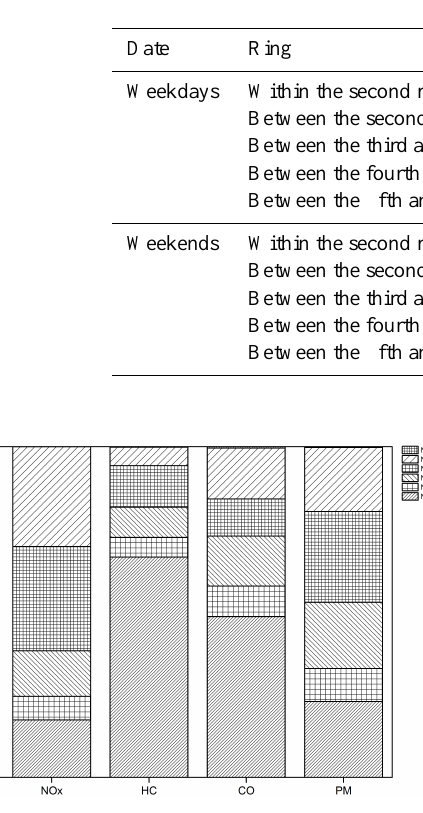
Figure 8. The vehicle emission contribution of different emission control